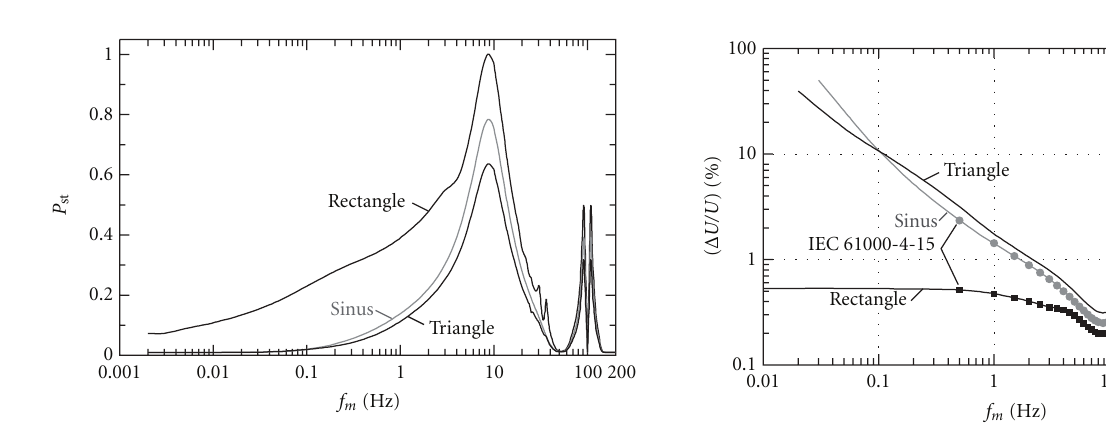
Figure 5: Plot of ( Δ U/U ) = f ( f m ) dependence for rectangular, sinusoidal, and triangular modulating signals with P 2 4 = 1 = const; black dots—Table 2 from [3], gray dots—Table 1 from [3].